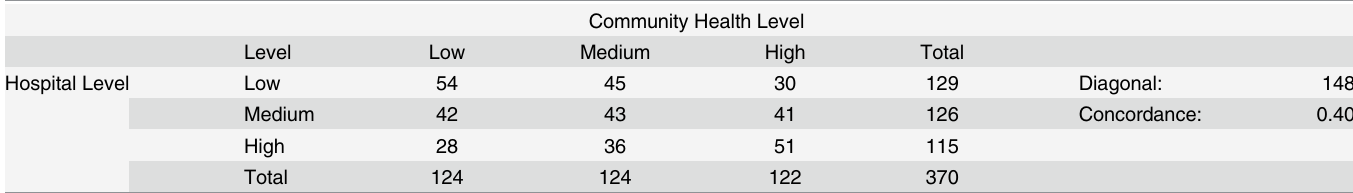
Table 3. Diarrhea Hospital Rates Versus CHW Reported